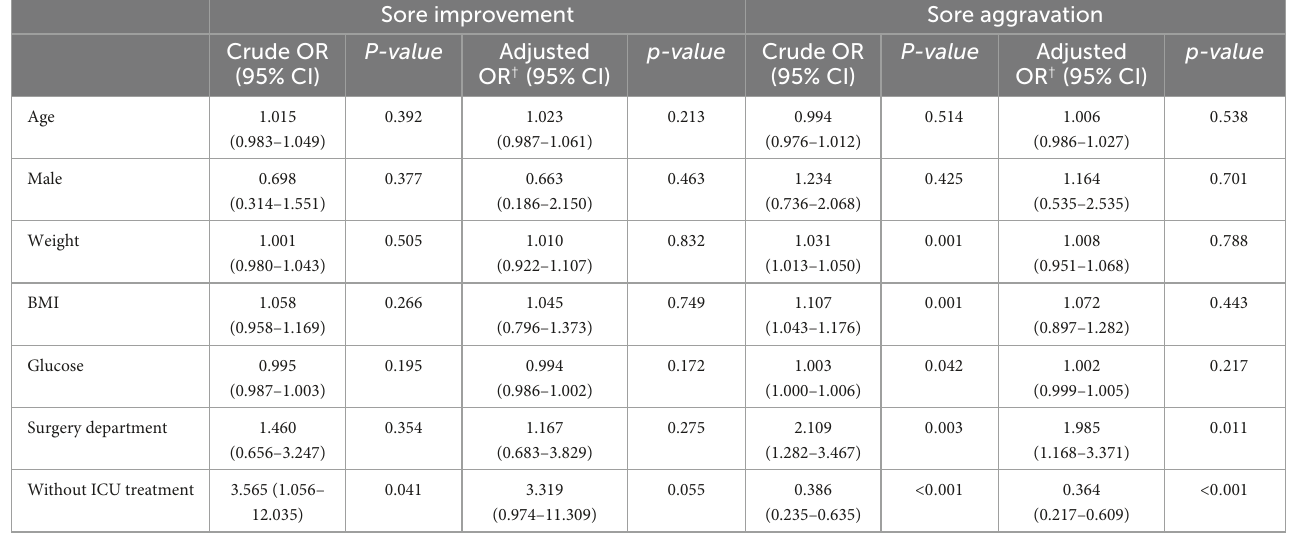
TABLE 4 Factors influencing changes in the pressure sore